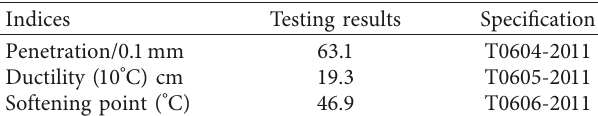
Table 2: Technical properties of 70# base asphalt. Table 3: Setting UV aging